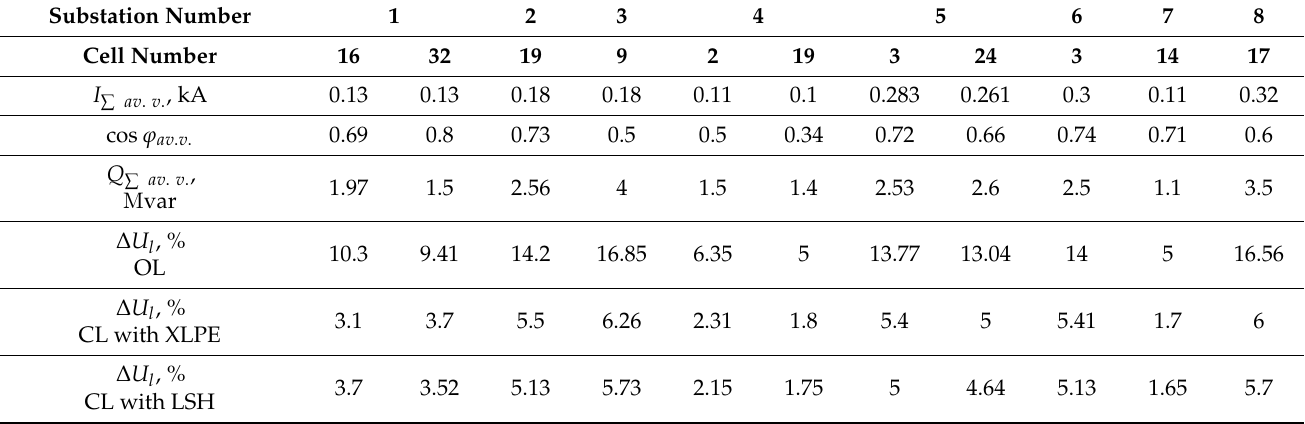
Table 4. Voltage losses in nodes with a maximum average current load at a known active power factor at